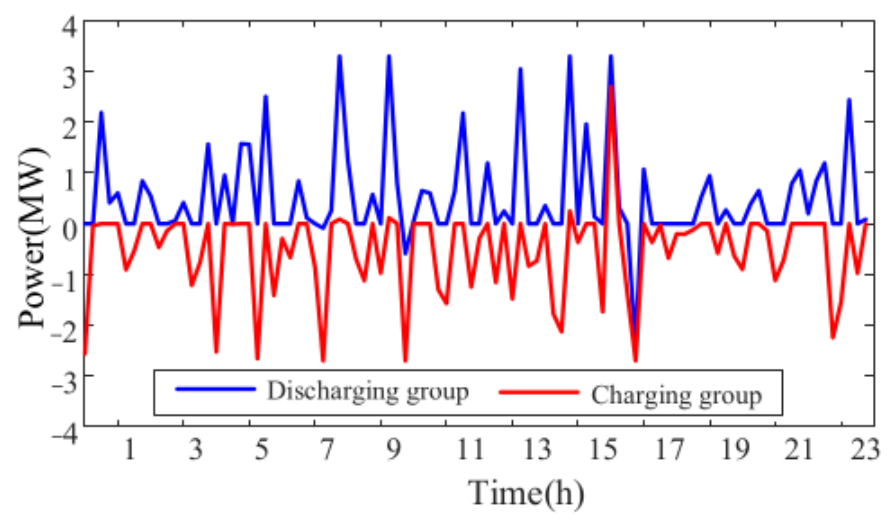
Figure 7. Power curves of charge and discharge